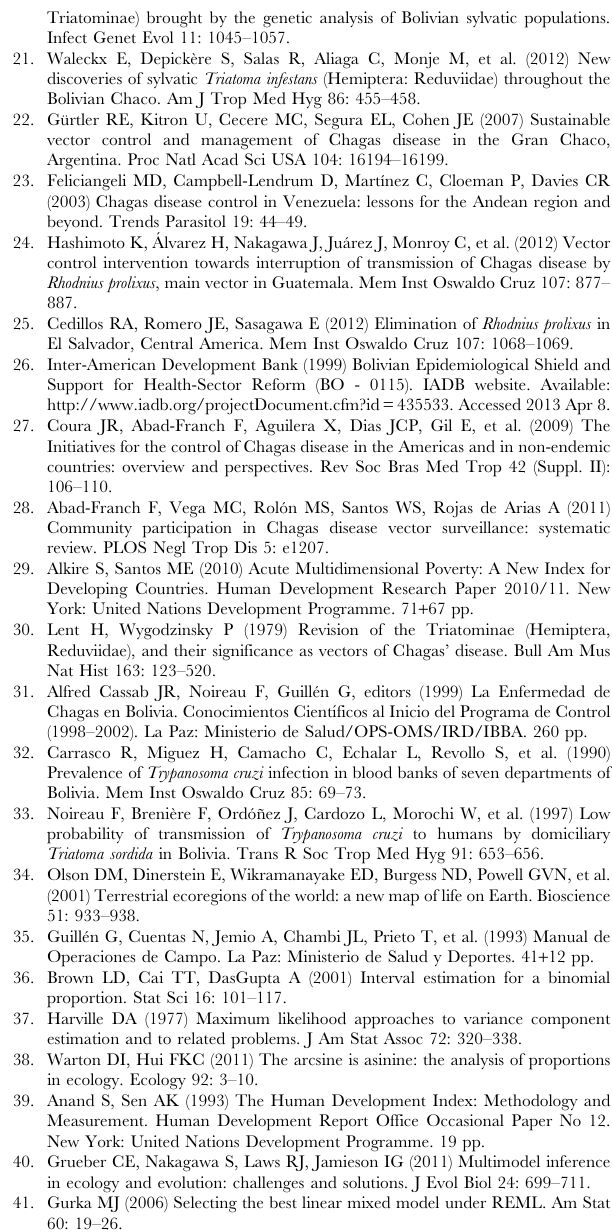
Table S1 Proportion of dwellings searched for triatomine bugs (P(searched)) during the activities of the Chagas Disease Control Program of the Department of Cochabamba, Bolivia, 2000–2011 (no activities were conducted in 2002), and dwelling infestation